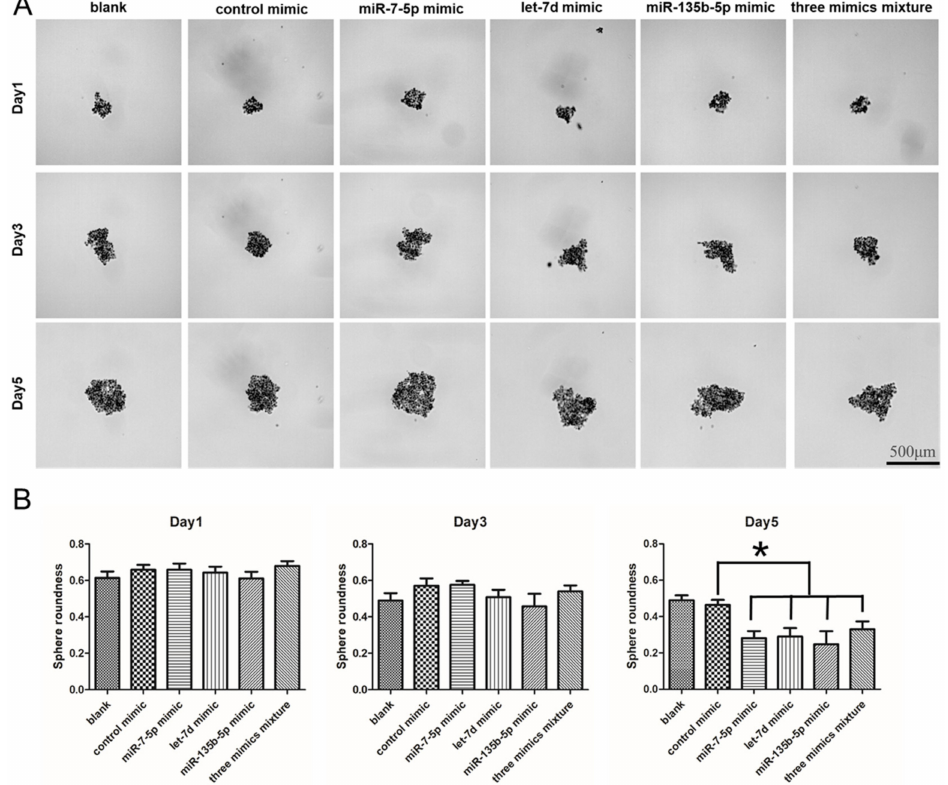
Figure 8. The sphere formation ability of PANC-1 treated with miRNA mimics. ( A ) Sphere images of di ff erent treated groups of PANC-1 on day1, 3 and 5. ( B ) The di ff erences of sphere roundness between di ff erent treated groups of PANC-1 on day1, 3 and 5. Data are presented as the mean ± standard deviation (SD) of three independent experiments. * P < 0.05 in comparison with the corresponding cells using Student’s t